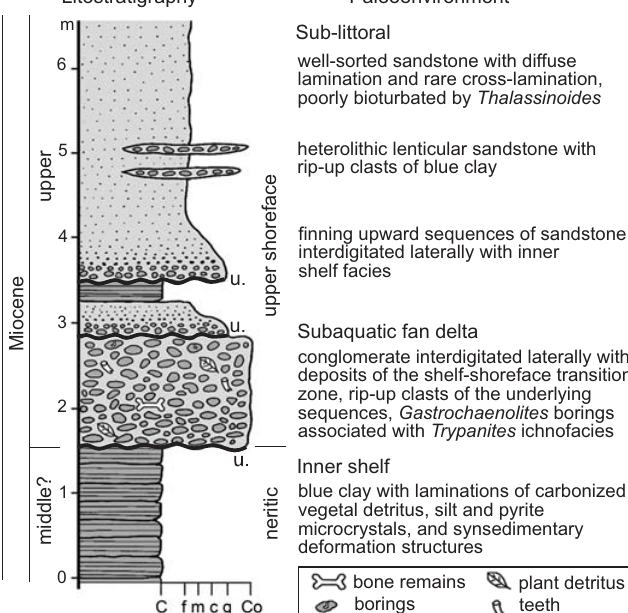
Fig. 2. Stratigraphic column of the fossil-bearing locality, San Gerardo de Limoncito, modified from Laurito and Valerio (2010). Abbreviations: C, clay; c, coarse sandstone; Co, conglomerate; f, fine; g, gravel; m, middle; u., unconformity.